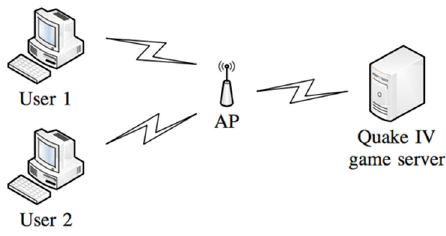
Figure 5. Short distance network topology.